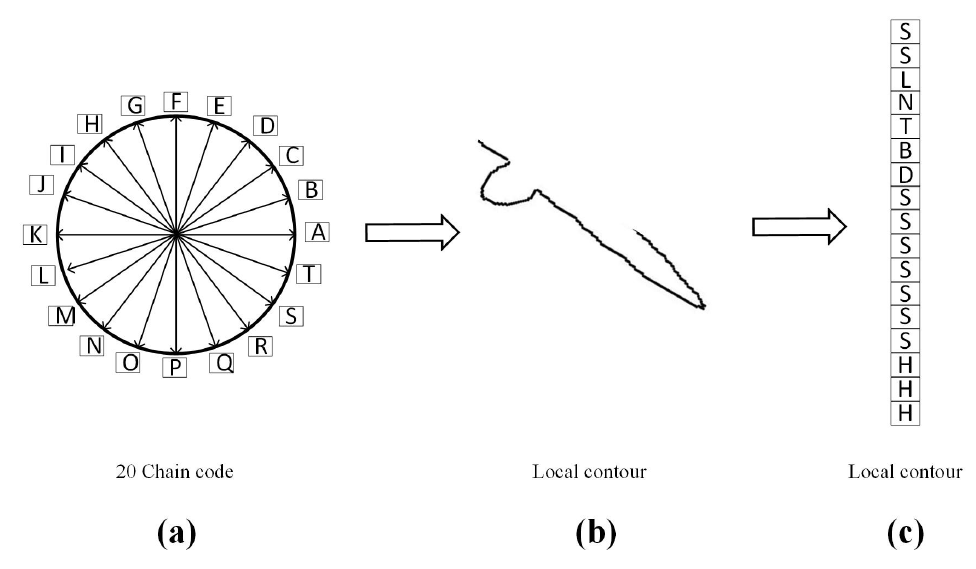
Figure 5. ( a ) The specified 20-orientation coding diagram, which contains 20-orientational code values, corresponding to the letters A–T. ( b ) a local contour, and ( c ) the code values of the contour in ( b ) after coding according to the specified coding rules (from top to